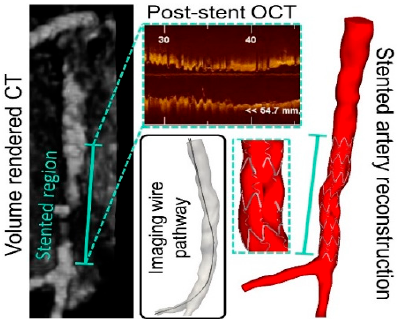
Figure 2. One method of patient-specific stented artery reconstruction. A coronary CTA is seeded with candidate points, and the OCT imaging wire path is calculated by minimizing total bending energy. The implanted stent is then replicated computationally. Adapted from Ellwein et al. [73]. Wu et al. recently created a reconstruction approach that is specifically tailored to bifurcation models created from patient-specific angiography, which then underwent OCT imaging and were compared to reference versions from contrast-enhanced microfocal computed tomography ( μ CT). The utility of the method was further scrutinized in seven diseased patient bifurcations of varying anatomical complexity. Agreement was high between reconstructions and reference morphology, as was reproducibility and the ability to conduct the reconstruction process within a reasonable amount of time (i.e., <1 h). This method has since been extended, with angiography and OCT data obtained directly from patients and with the addition of local linkages resulting from deployment through the optimization of several bifurcation stenting techniques [75]. Other approaches in the combination of conventional extravascular and high- resolution intravascular imaging data to reconstruct the stented flow domain are also presented with varying degrees of detail in the literature [70,76–79]. Recently, Li and colleagues described their process using 3D angiography and OCT imaging, which was featured for diseased coronary artery data sets [80] as well as those obtained after bioresorbable vascular scaffold (BVS) implantation [58]. Their approach pays particular attention to the inclusion of side branches that are likely to impact the local flow field. A similar approach was employed for BVS by Migliori et al., who further quantified restenosis and neointimal thickening [76]. Gogas et al. developed a similar process that is highlighted via a BVS case study [77,78]. Their approach is noted for including semiautomated lumen extraction and strut detection via shape recognition algorithms within each OCT image. These data are then aligned while accounting for patient curvature. The choice of which intravascular imaging modality is to be used in each approach (e.g., OCT vs. IVUS) depends on many factors, such as those present from a clinical perspective that are related to the need for contrast, onboard versus offline plaque characterization protocols as well as clinical preference and the availability of each clinical imaging system within a given catheterization laboratory. While acknowledging these considerations, studies have suggested that patient-specific arteries created from OCT and IVUS runs of the same atherosclerotic arteries may be highly correlated [81]. In contrast, when conducted after stenting, it appears that there can be significant differences in clinical endpoints such as the thickness and area of neointimal tissue that impact local blood flow patterns manifesting in the WSS imposed on the endothelium [82]. These differences seem to be a result of improved resolution afforded by OCT. It is important to note that to date, the inclusion of stents in computational models of reconstructed arteries has ranged from the general contour traced out by stent struts in intravascular images while ignoring the local struts and their associated perturbations, to the incorporation of residual stresses and strains experienced during balloon folding and pleating and stent crimping. Particularly noteworthy is the work of Chiastra et al., which